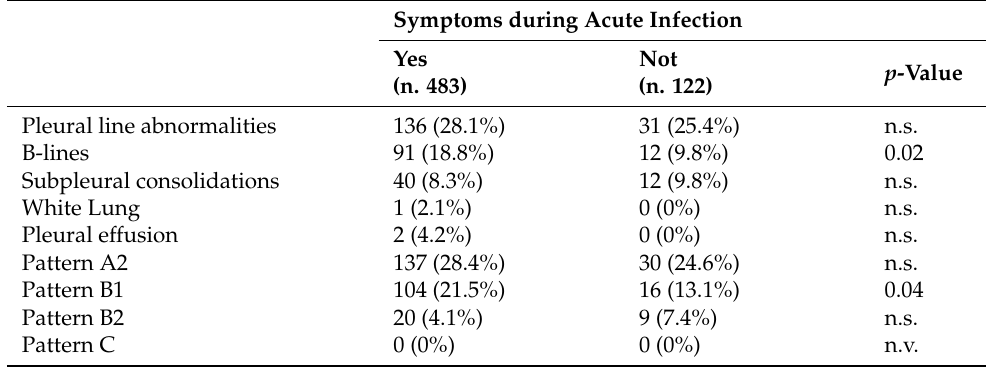
Table 3. Association between patterns/artifacts lung ultrasound and symptoms during acute